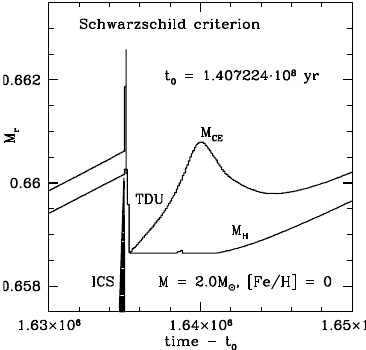
Figure 2. An example of the thermal-pulse and TDU sequence in a low mass AGB star of solar metal- licity. It is the nineth cycle of this type in the model star. 14 N from CNO processing is present below the H-burning shell, before the onset of the ICS; in the intermediate convective region it becomes 22 Ne through a double α capture. This last burns only marginally, releasing modest neutron fluxes through 22 Ne( α ,n) 25 Mg. Most of the neutrons for s -processing are however released below the TDU, following first the penetration of protons, then the reaction 12 C(p, γ ) 13 C, and finally the 13 C( α ,n) 16 O